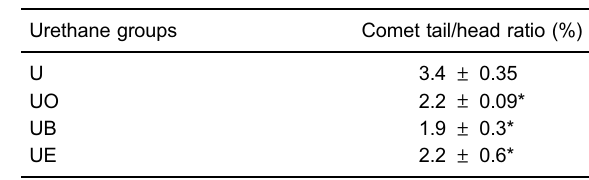
Figure 3. Lipid peroxidation in lung specimens of mice. A , In urethane-injected mice (U), lipid peroxidation was higher than in control mice (C) (P=0.05). B , In animals that received daily doses of antioxidants, the degree of lipid oxidation was lower than that observed in urethane-injected mice (P o 0.05). Data are reported as means ± SD for urethane-injected and control mice (n=5) and urethane-injected and supplemented mice (n=10). U + O: urethane + pequi oil; U + E: urethane + pequi ethanolic extract; U + B: urethane + beta-carotene. *P o 0.05, ANOVA and t -test.